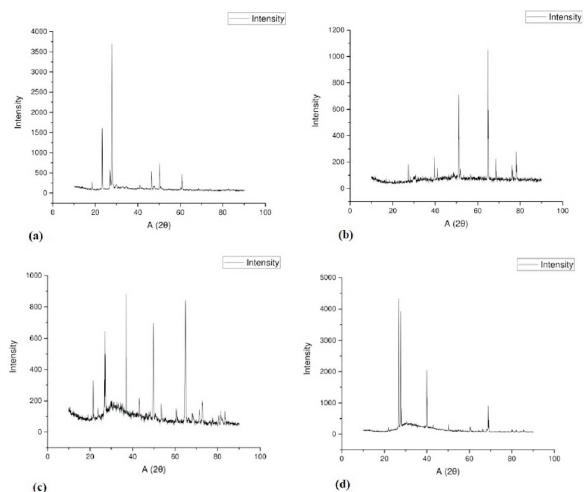
Figure 4. XRD for affirmation of calcite formation due to bio-mineralization. (a) Conventional concrete with the absence of CaCO 3 , (b) Positive control with in- creased CaCO 3 , (c) The isolated Bacillus pumilus KC845305 with increased CaCO 3 and decreased CaO, (d) The isolated Bacillus flexus KC845306 with increased CaCO 3 and decreased